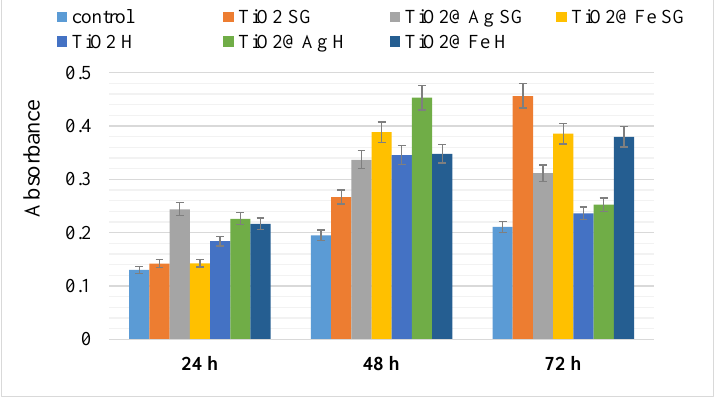
Figure 10. MTT analysis performed on the samples obtained by sol-gel and hydrothermal method.